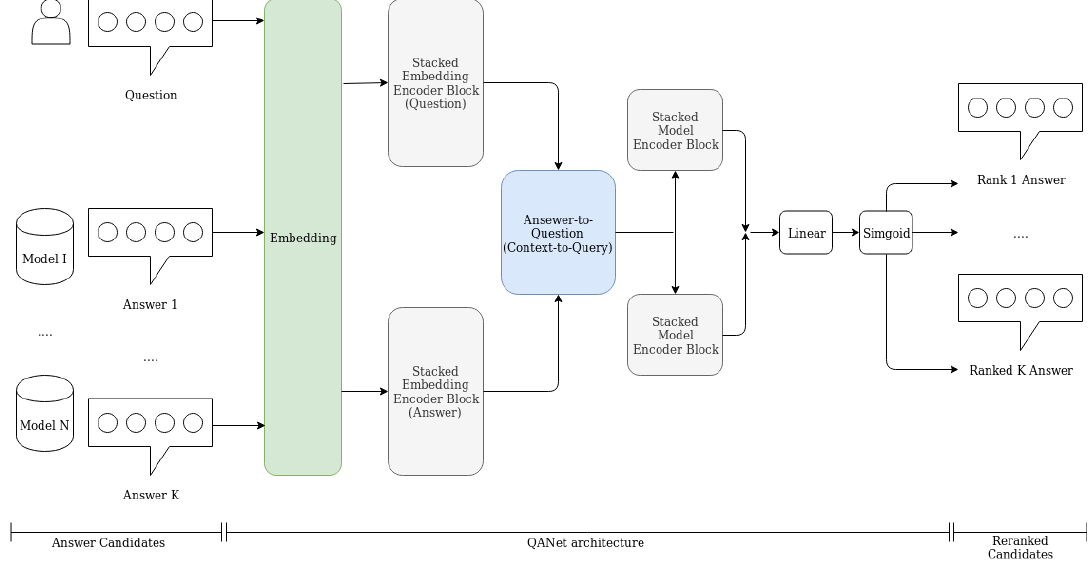
Figure 1. Our answer re-ranking framework, based on the QANet